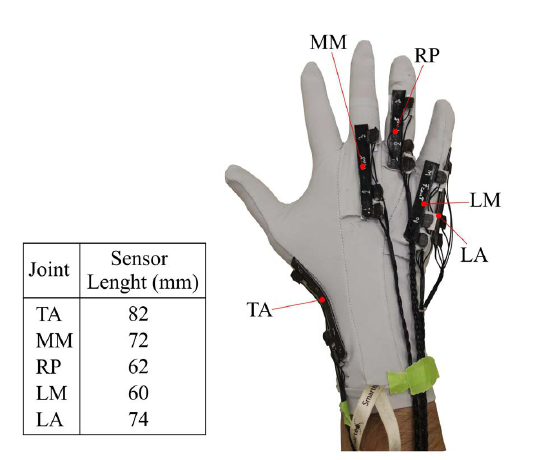
Figure 4. The kinaesthetic glove. According to the optimal design criteria, the five KPF goniometers are placed on TA, MM, RP, LA and LM joints of the